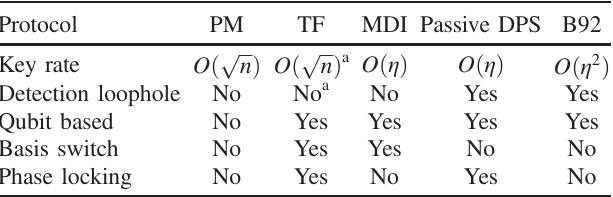
TABLE II. Comparison of different QKD protocols: PM-QKD; TF-QKD [16]; MDI-QKD [15]; passive differential phase-shift (DPS) QKD [21]; Bennett-1992 (B92) QKD [20]. Key